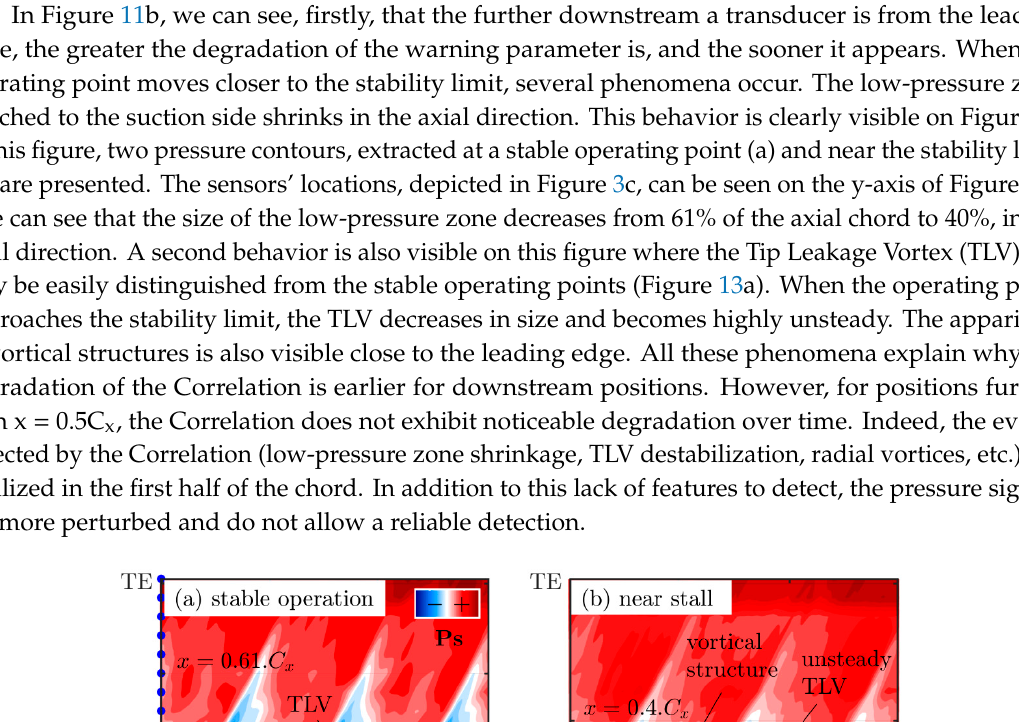
Figure 14. ( a ) irregularity rate evolution at five angular positions for a constant threshold and ( b ) optimized thresholds depending on the sensor location. x = 0.55Cx, moderate throttling speed.